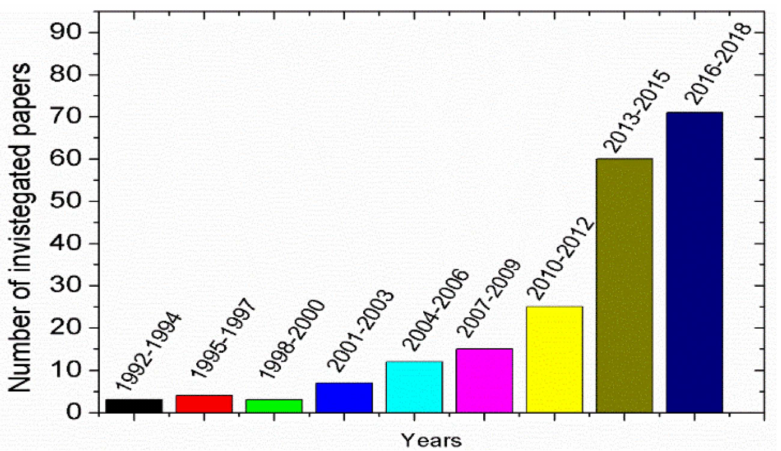
Figure 4. Investigated papers according to